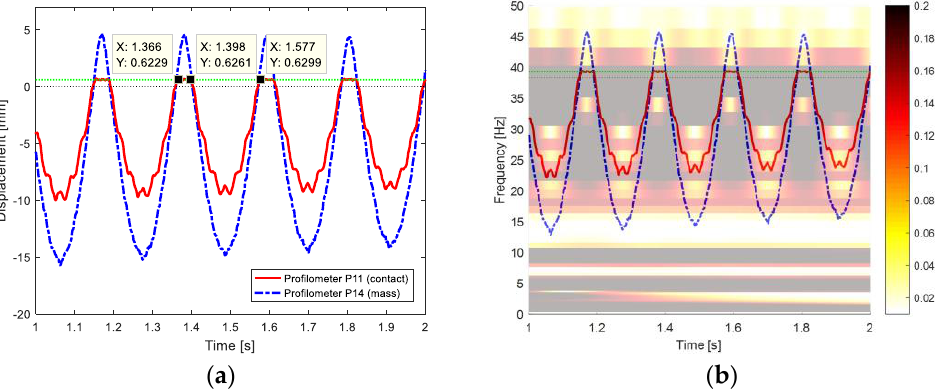
Figure 17. Instants of contact ( a ), and combination with CWT analysis ( b ); red line identifies the detected intermedial point, blue line the point detected at the mass.